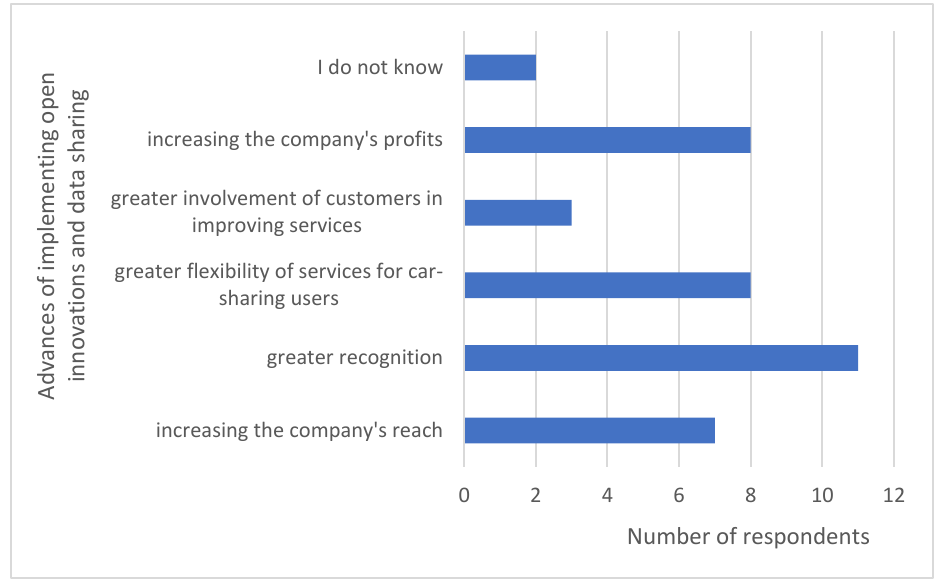
Figure 6. Advantages of implementing open innovation and data sharing in car-sharing systems.